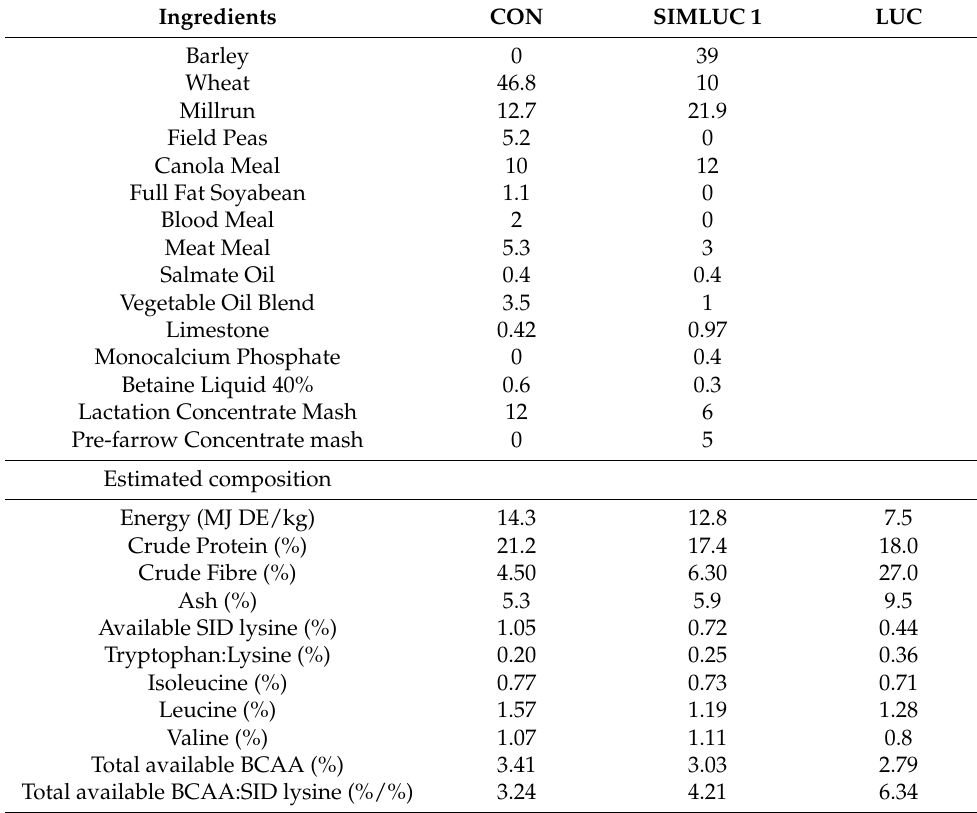
Table 1. Composition of experimental diets fed in late gestation and 3 days after farrowing (% as fed) in Experiment